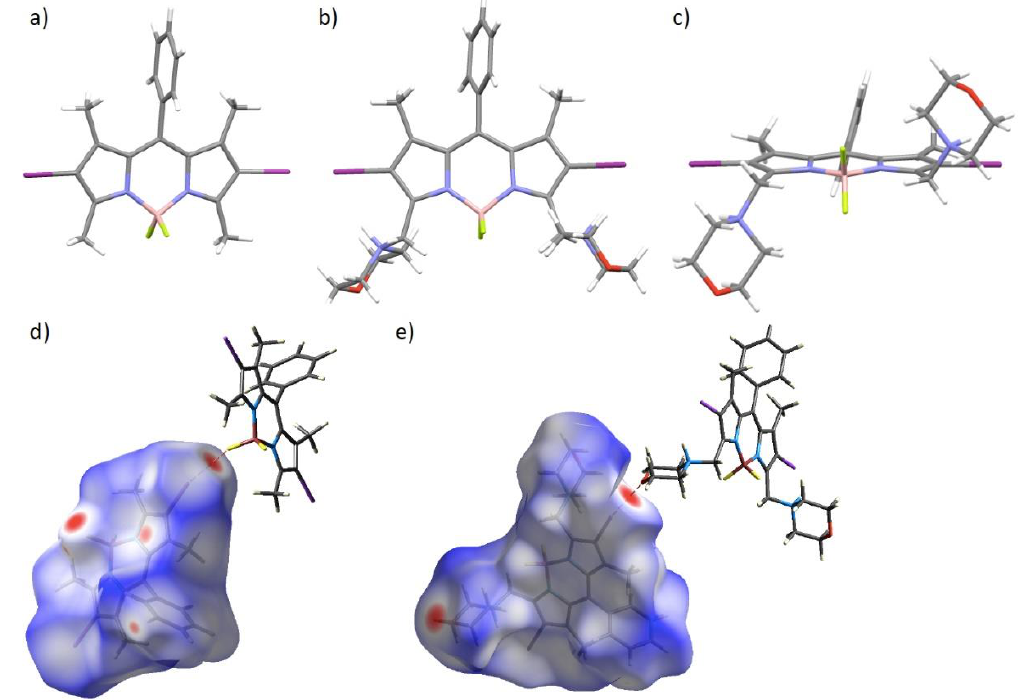
Figure 1. Crystal structure of ( a ) 2 and ( b , c ) 3 , in the latter case illustrating the relative orientation of the morpholino substituents in relation to the dipyrrin core; ( d ) Hirshfeld surface representation of (d) C–I ⋯ F interaction in 2 and ( e ) C–I ⋯ O interaction in 3 . C = grey, N = blue, B = pink, F = green, I = purple, O = red, H = white.